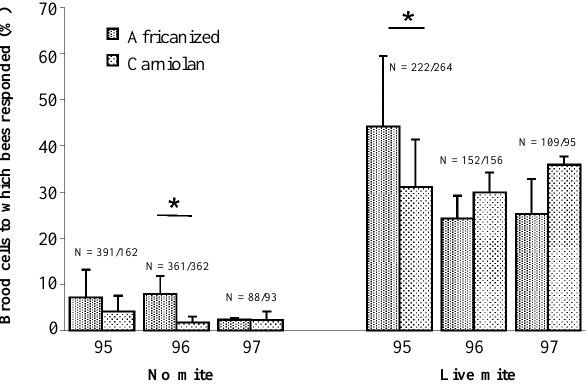
Figure 2 - Hygienic reactions of Africanized and Carniolan honey bees in different years (N = number of manipulated brood cells). Africanized honey bees responded to a significantly higher percentage of cells artificially infested with live mites only in 1995 ( χ 2 = 5.2, P = 0.03) and of control cells in 1996 ( χ 2 = 5.4, P = 0.03).